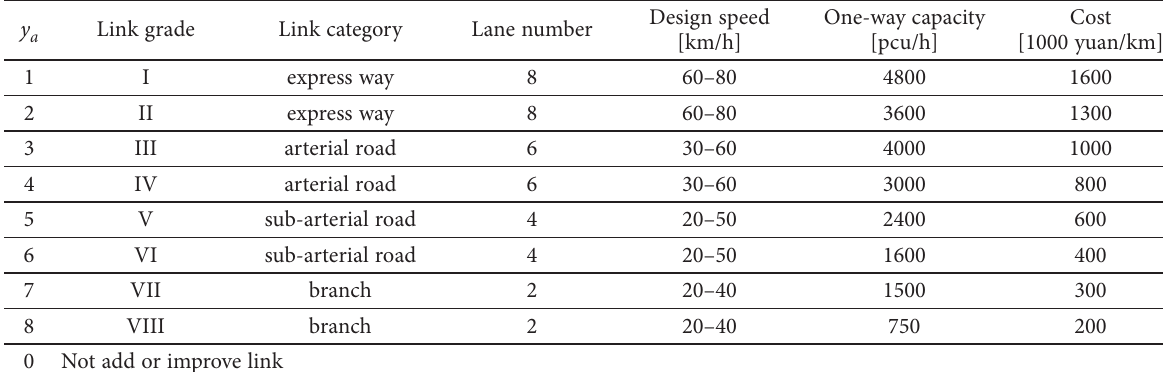
Table 1. Values of y a and the corresponding link